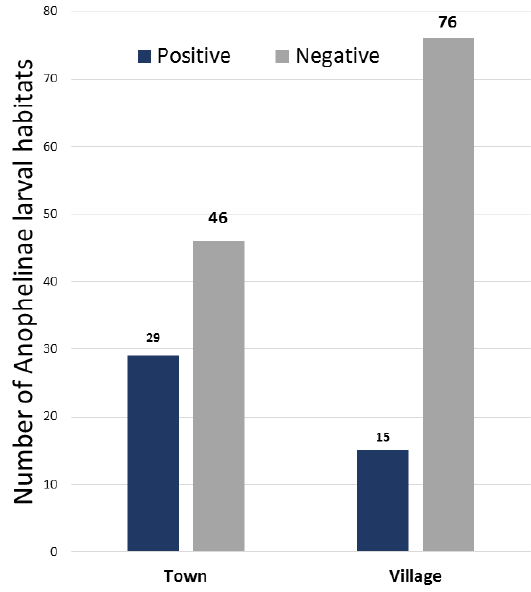
Figure 4. Number of Anophelinae larval habitats in town and